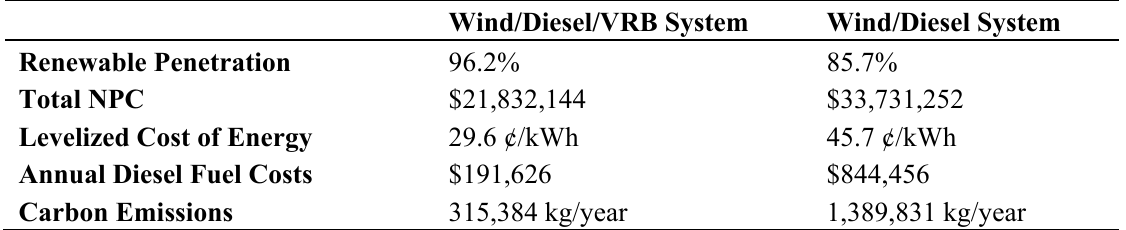
Table 6. Comparison of identical wind/diesel systems with and without a